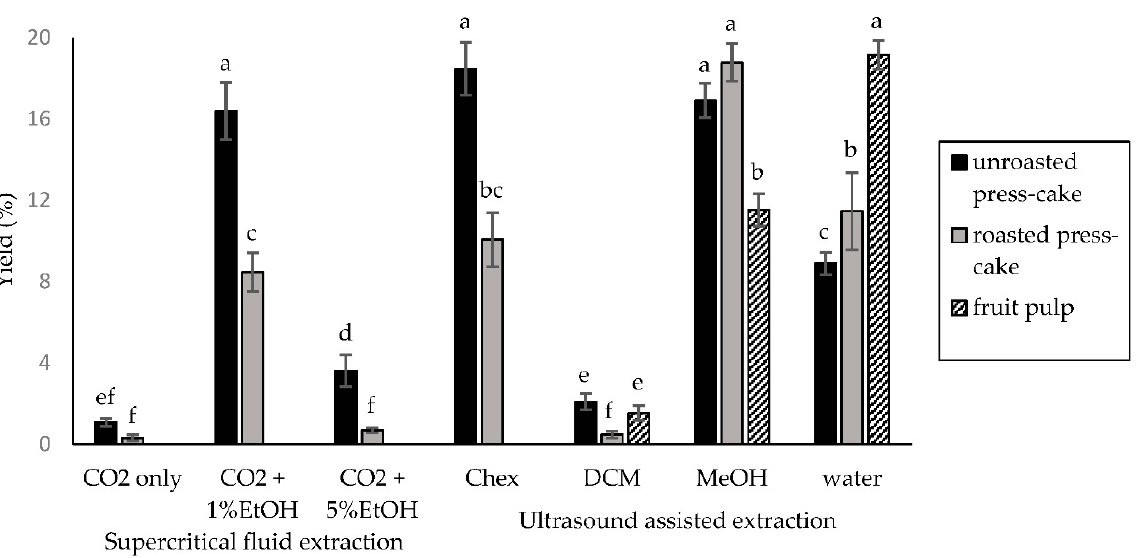
Figure 4. Extraction yields of argan press cakes and fruit pulp (a–f letters represent significant differences at p < 0.05 by the Newman–Keuls test).